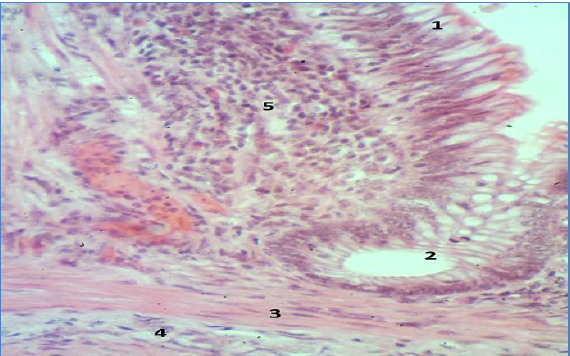
Figure, 3: magnified section of coproedeum villus (hen turkey) shows: epithelium (1), epithelial gland (2) muscularis mucosa (3), submucosa (4), and lymphocytic nodules (H and E) satin. 400x.